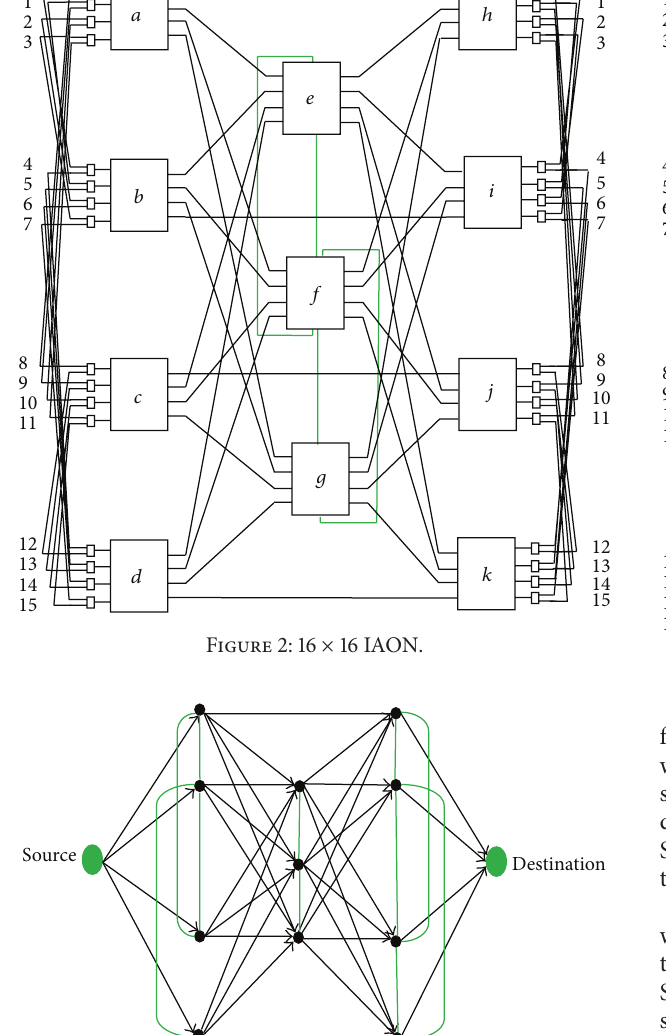
Figure 3: Redundancy graph of IAON.